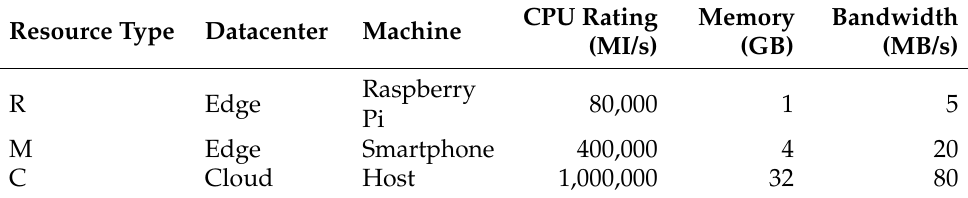
Table 3. Edge and cloud resource